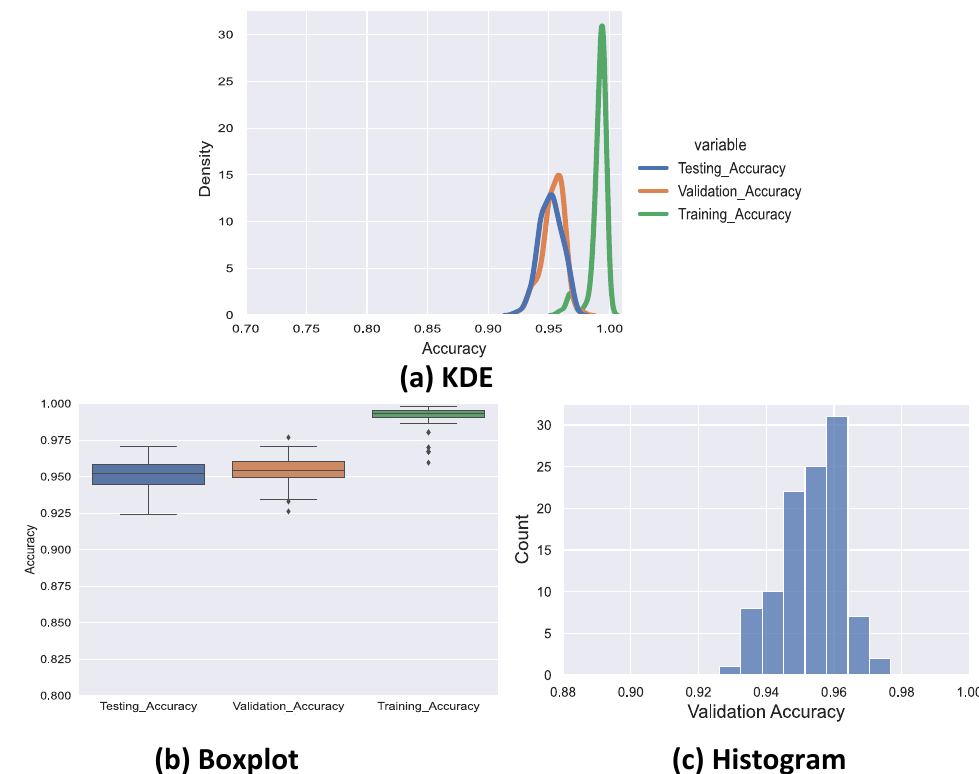
Figure 10. Kernel density estimation ( a ) and box plot ( b ) for all sets accuracy; histogram only for validation set accuracy ( c